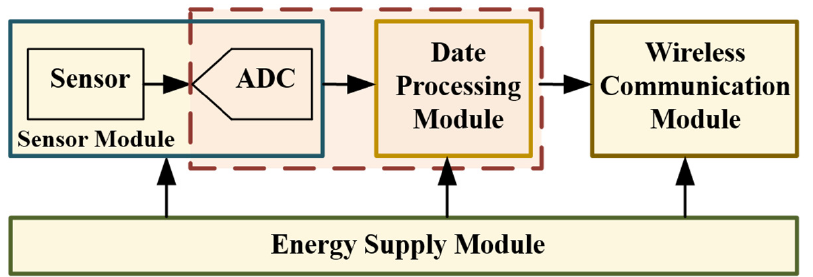
Figure 1. The sensor node structure.